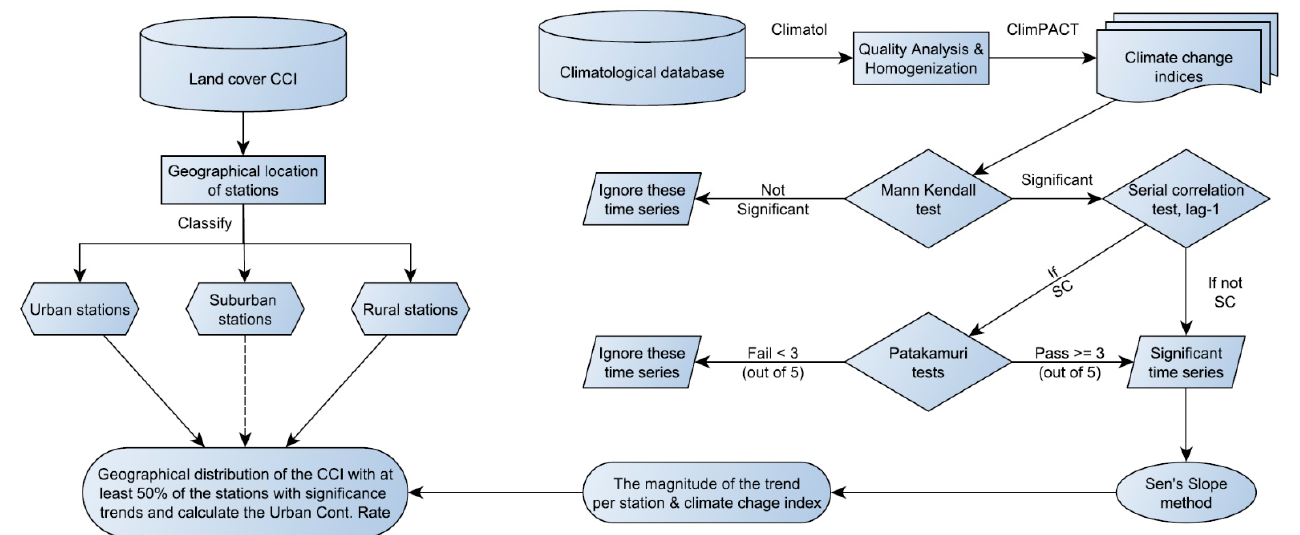
Figure 1. Flowchart with the relevant steps followed in the method of this study.